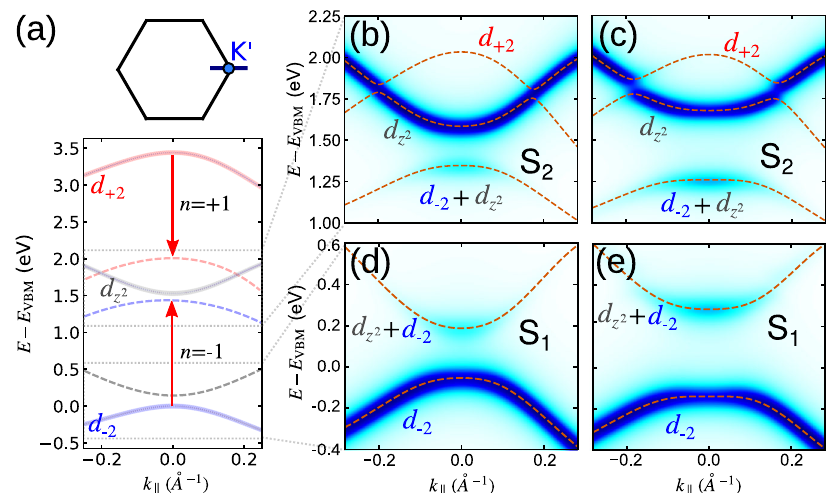
Fig. 4 Orbital character of Floquet side bands. a Sketch of the band structure and dominant orbitals near K 0 along the sketched path in reciprocal space. The dashed lines are periodic replicas of the bottom conduction band (gray), top valence band (blue), and a higher conduction band (red), respectively. b Zoom into the region close to the side-band features S 2 in Fig. 3 for E 0 = 1× 10 − 3 a.u., and c E 0 = 2 × 10 − 3 a.u. peak fi eld strength. d Zoom into the region of S 1 for